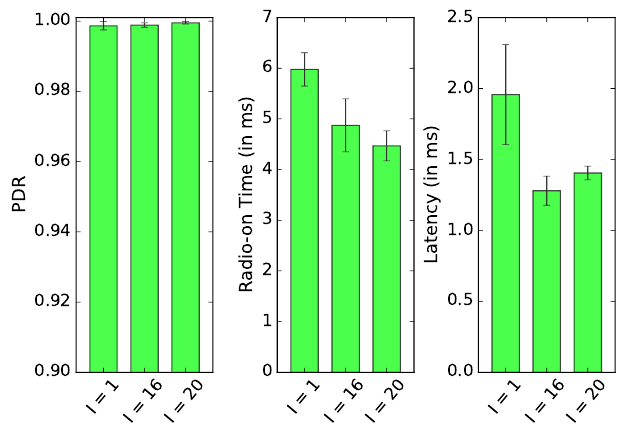
Figure 9. Performance metrics of LiM with various initiator positions using a transmission power of -7 dBm. Even with relatively weak link connections, the network can still provide high reliability, low radio-on time, and low